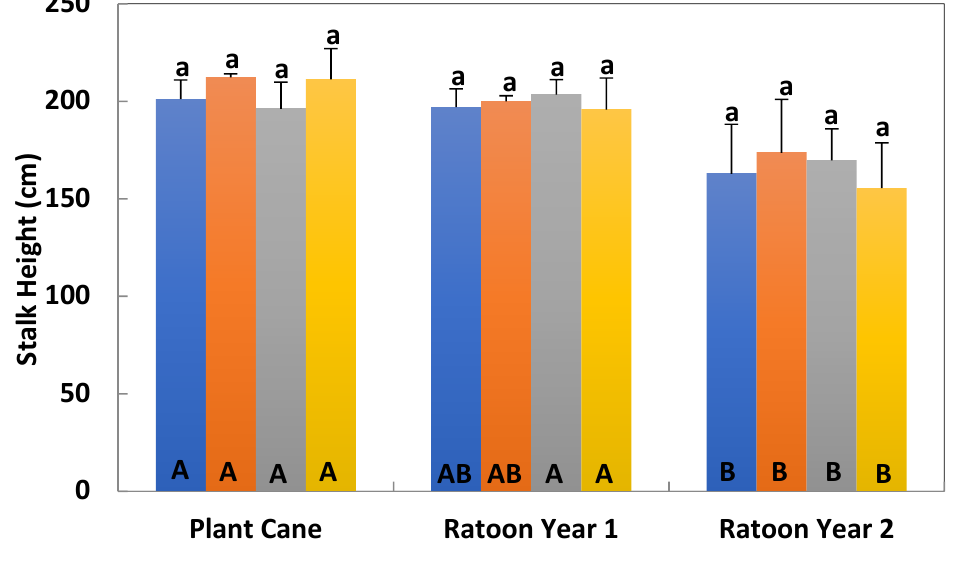
Figure 2. Stalk height for plant cane and two ratoons (mean and standard deviation). Different lower case letters within the same crop year are significantly different ( p < 0.05). The same treatment with different upper case letters for plant cane and two ratoons are significantly different ( p < 0.05).